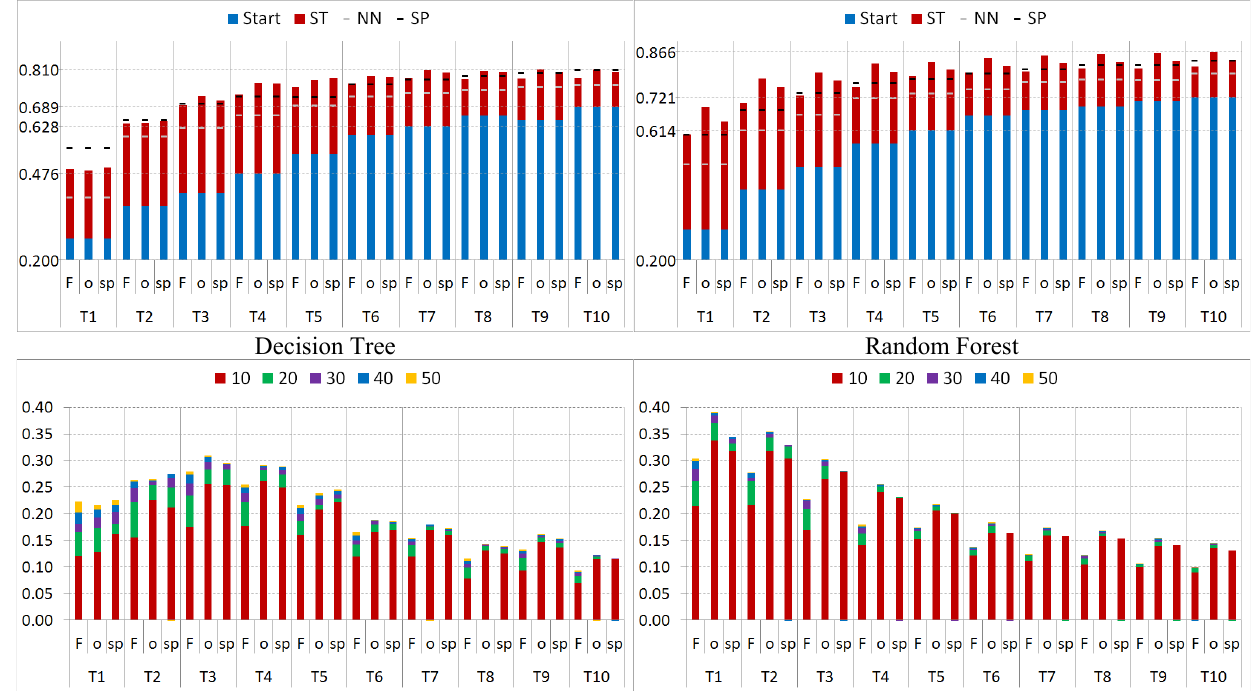
Figure 11. Top row: Classification accuracies for different training sets, T selection methods for the unlabeled samples. Dashed lines show results for enlarging T with NN and superpixel (SP). Bottom row: Improvements of self-training (ST) per 10th iteration for the two base learners. The selection methods are abbreviated as F ( full ), o (NH ), and sp (NH o sp